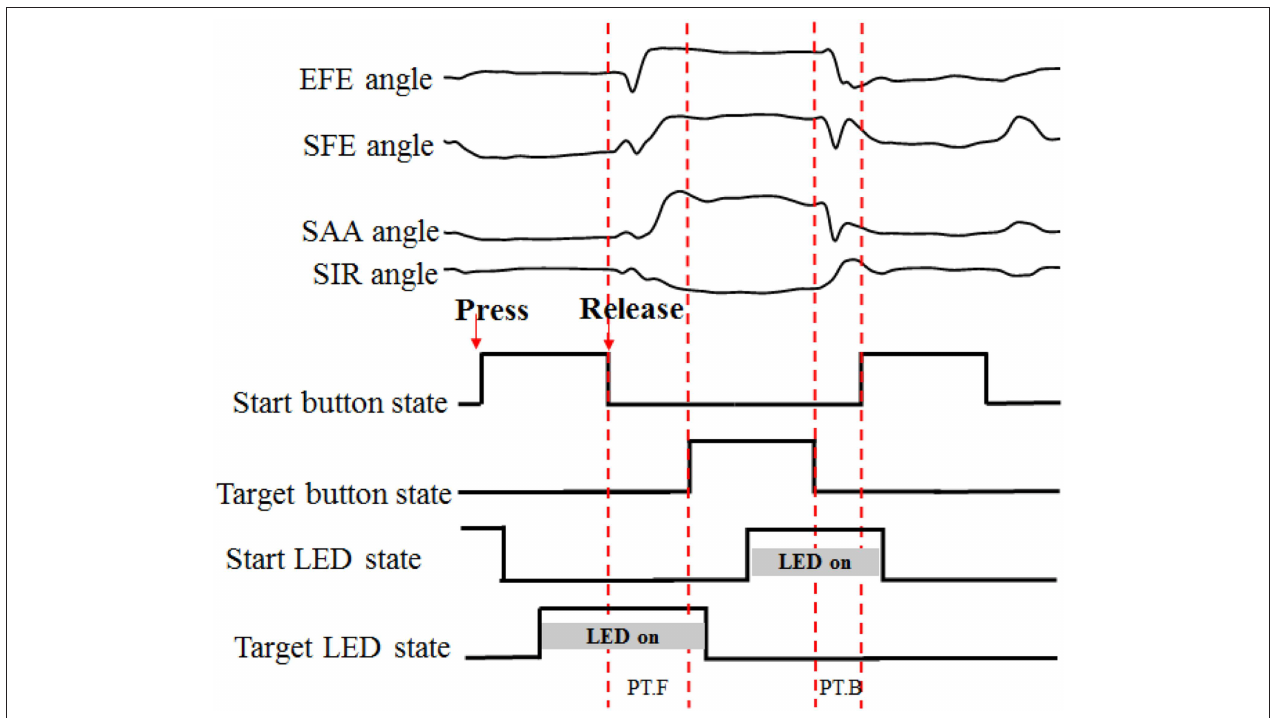
FIGURE 3 | Data segmentation process. “PT” for performance time, “F” and “B” for forward and backward, respectively. When the start button or target button was pressed, the LED was turned off.